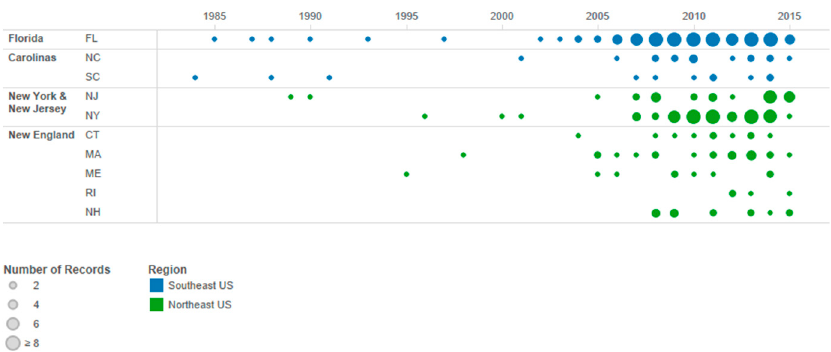
Figure 5. Spatial and temporal patterns of climate adaptation literature (pooled for academic and all-source databases) across Regions, Subregions, and States of the U.S. Atlantic coast, 1980–2015.